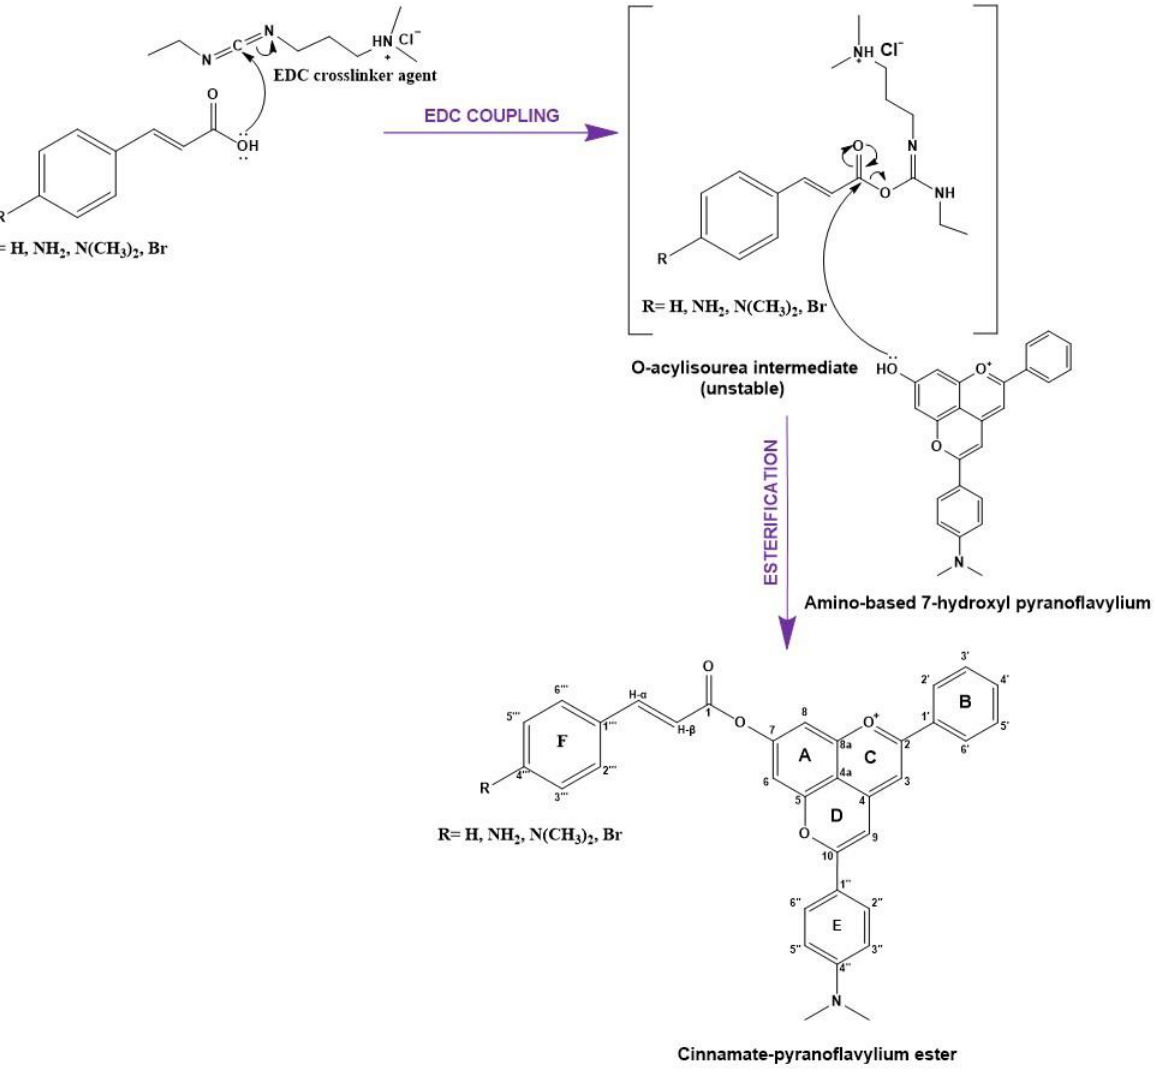
Scheme 1. Mechanism of formation of the ester compounds from amino-based 7-hydroxyl pyra- noflavylium and cinnamic acids derivatives using EDC coupling agent.